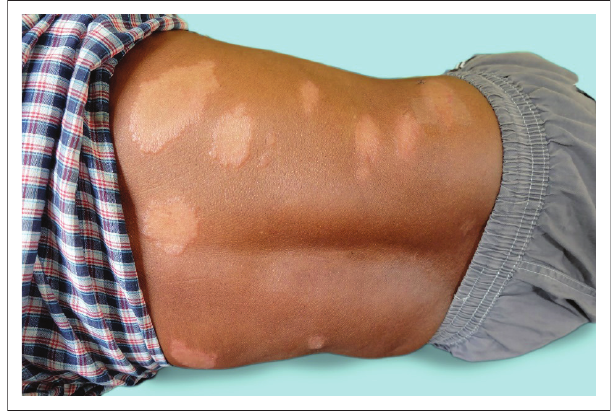
FIGURE 7: Tuberculoid leprosy